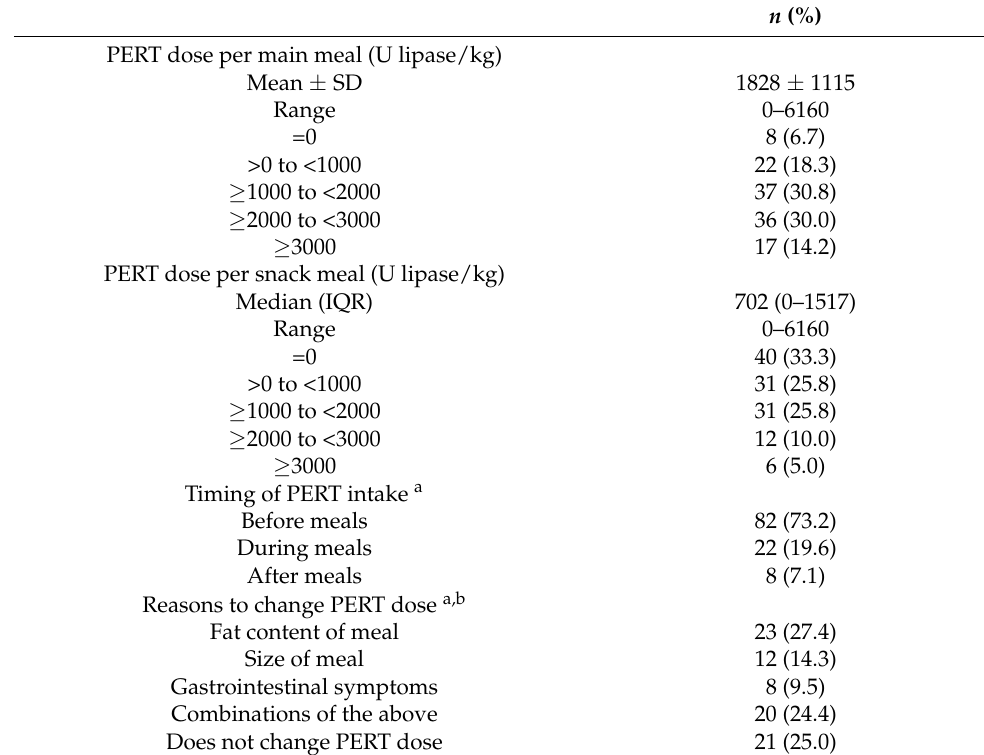
Table 2. Use of pancreatic enzyme replacement therapy in 120 adults with cystic fibrosis.